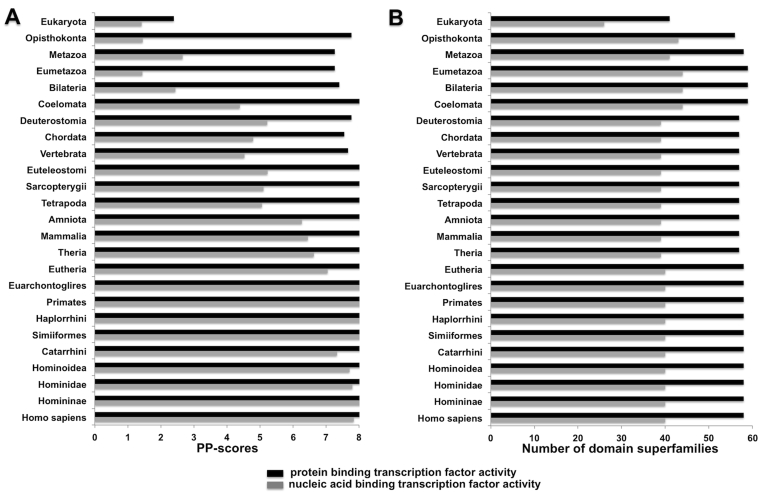
Patterns of transcription factor activities in terms of PP-scores (A) and the number of domain superfamilies (B) in the course of evolution leading towards human.